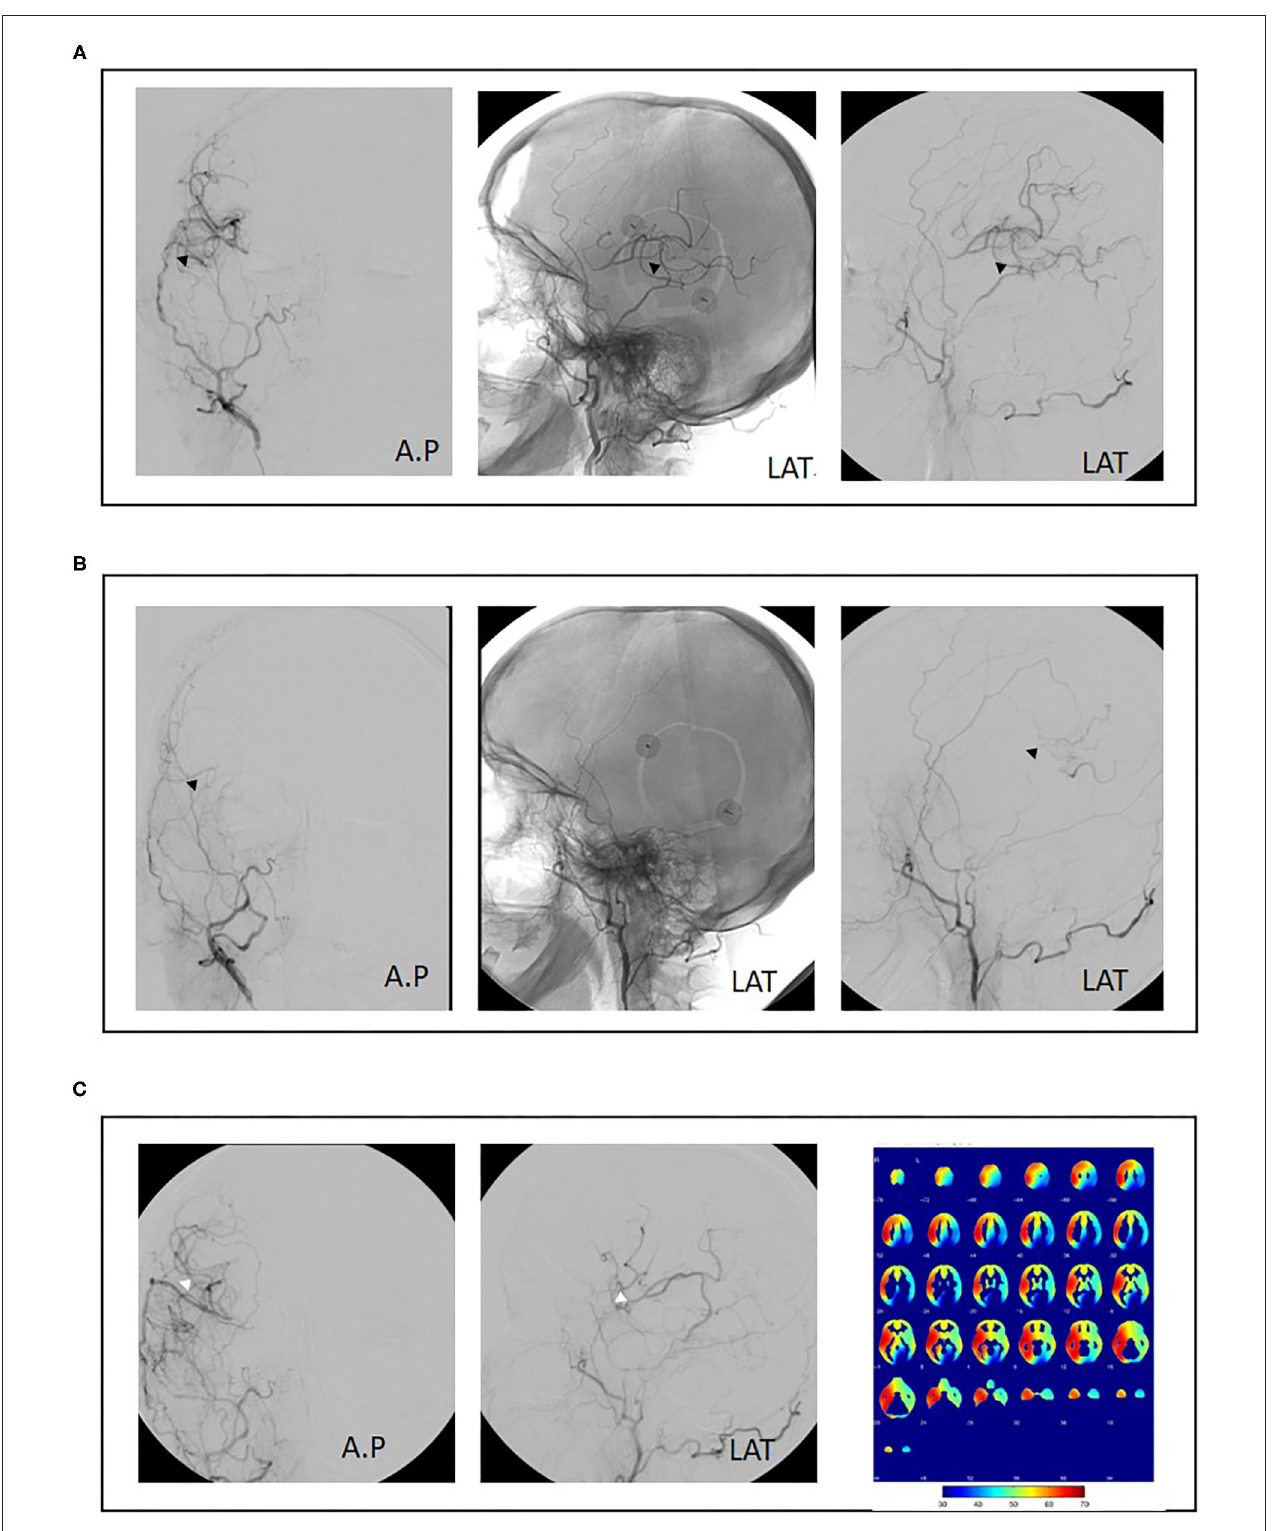
FIGURE 2 | Case example of repeat revascularization using superficial temporal artery to middle cerebral artery (re-STA-MCA). A 50-year-old female patient with bilateral moyamoya disease and right hemispheric transient ischemic attacks (TIAs) was treated with combined revascularization using STA-MCA (parietal branch) plus encephalodurosynangiosis (EDS) of the right hemisphere ( A , black arrowheads). Postoperatively, no new neurological symptoms were observed. Eight months